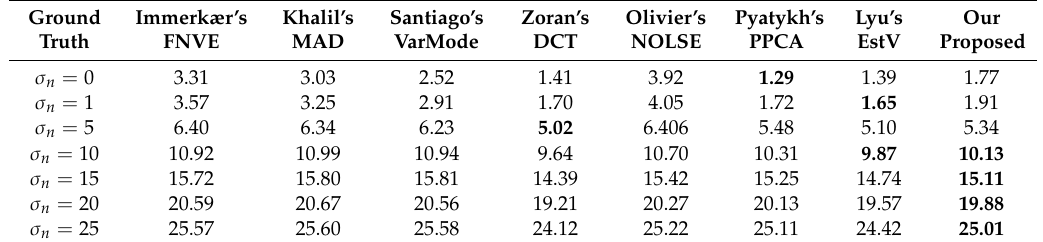
Table 1. The results of di ff erent AWGN estimation algorithms on the classic standard test images (CSTI). Ground Truth